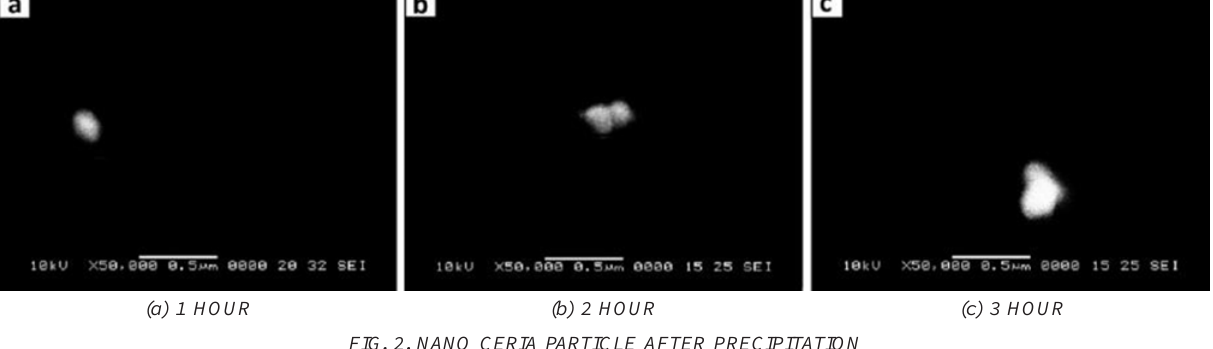
FIG. 2. NANO CERIA PARTICLE AFTER